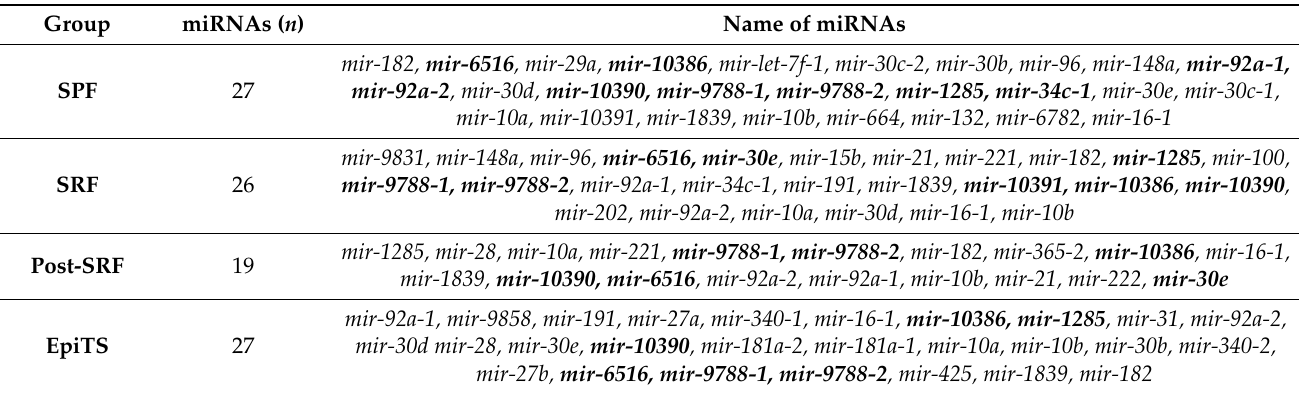
Table 2. List of identified miRNAs with different abundance among spermatozoa from three ejaculate fractions: sperm peak fraction (SPF), sperm rich fraction (SRF), and post-SRF of mature boars ( n = 6), and the epididymal terminal segment